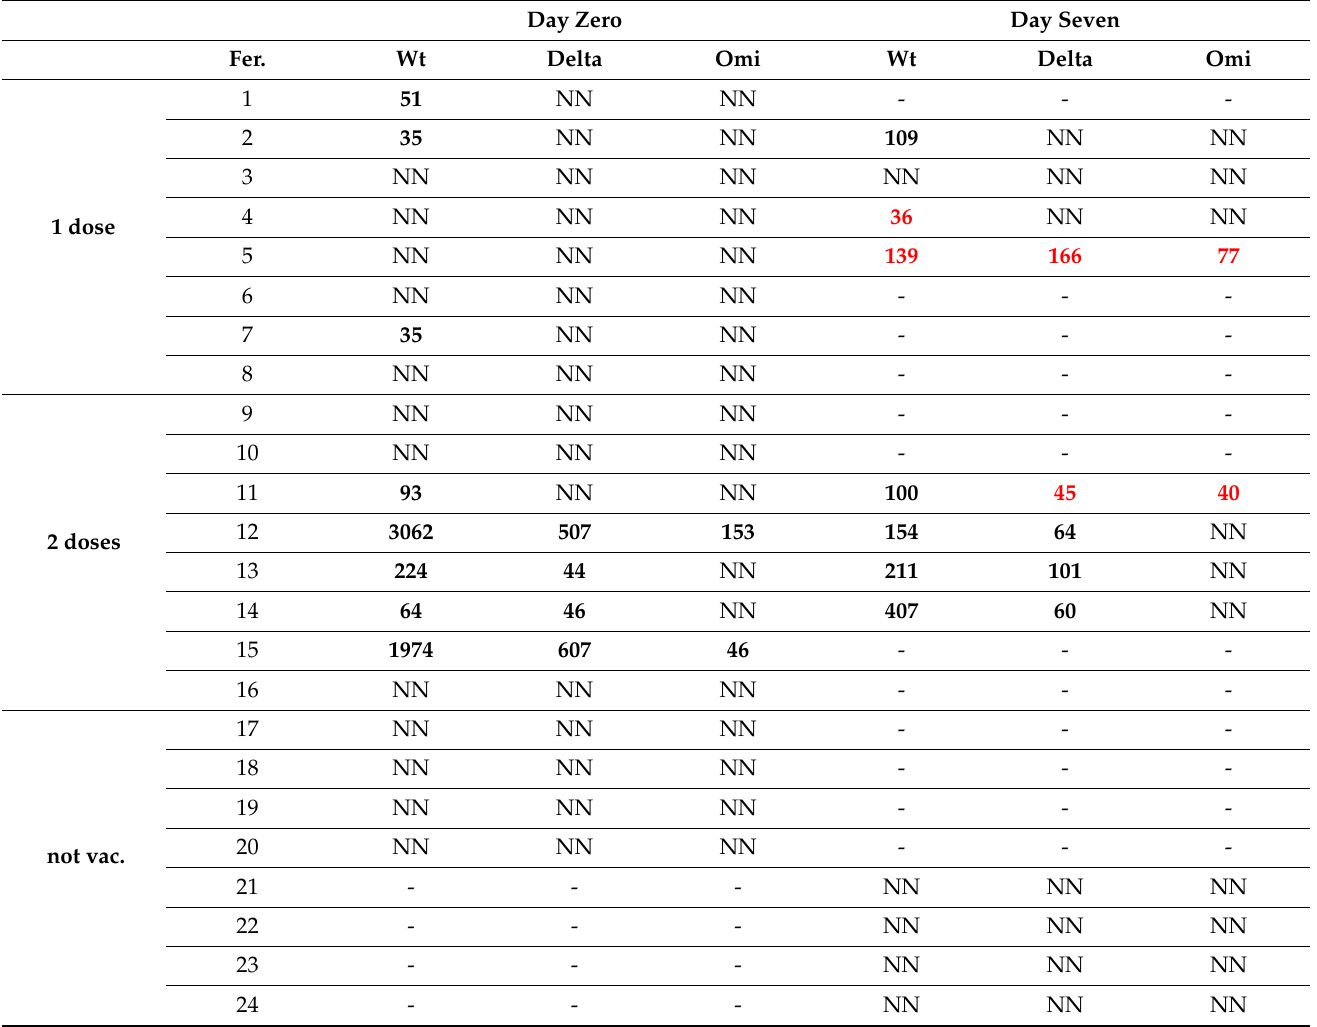
Table 1. Neutralization titers against VOCs. Not neutralizing sera